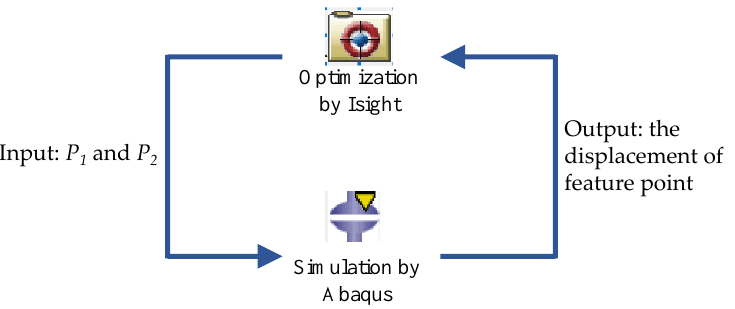
Figure 6. Optimisation process of the fingertip using Isight and Abaqus software.